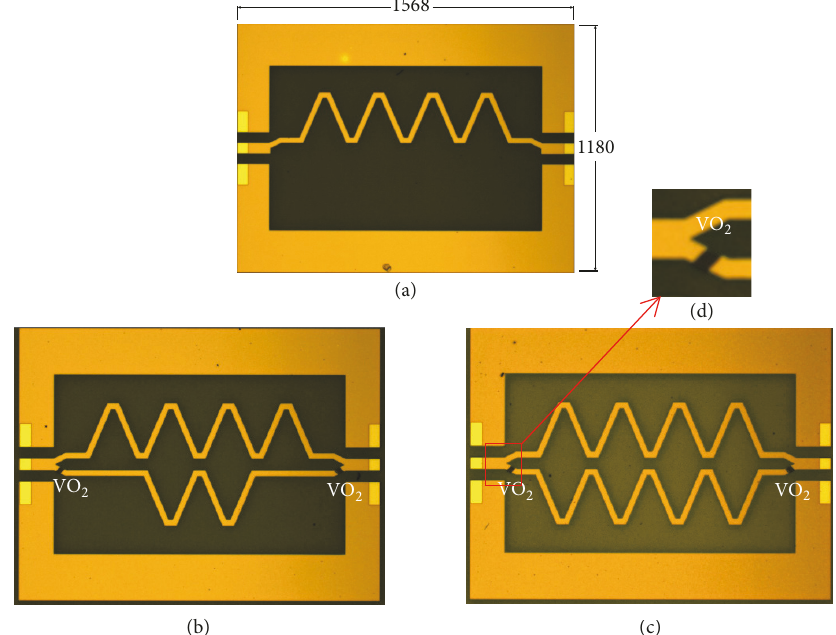
Figure 1: Top views of fabricated tunable inductors structures with (a) single line coil inductor, (b) dual line coil inductor with two turns in the bottom coil, and (c) dual line coil inductor with four turns in the bottom coil. Yellow areas are gold. Black areas on the yellow wires are the VO 2 stubs. The dimension of VO 2 is 23.1 𝜇 m × 26.3 𝜇 m shown in (d). All units are in 𝜇